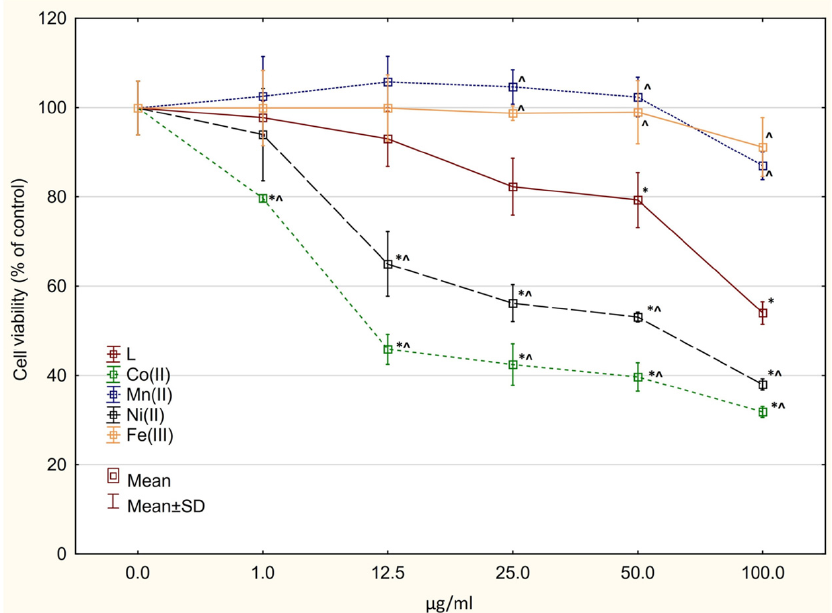
Figure 7. Cytotoxic activity of the investigated complexes and the ligand alone against U87 MG cancer cells. * p < 0.05 vs. control culture, ^ p < 0.05 vs. ligand (in corresponding concentrations).